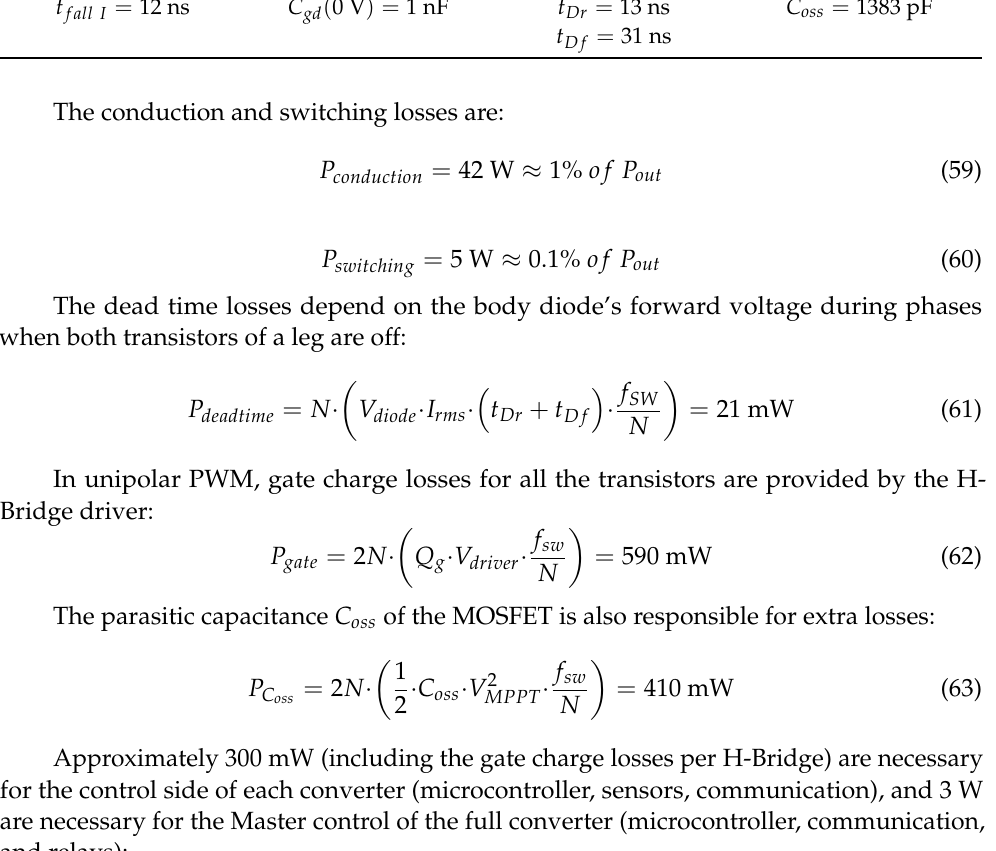
Table 7. Parameters of the DMTH6004SK3. Parameters of the DMTH6004SK3 = 3.8 m R ds − on 50 ◦ C